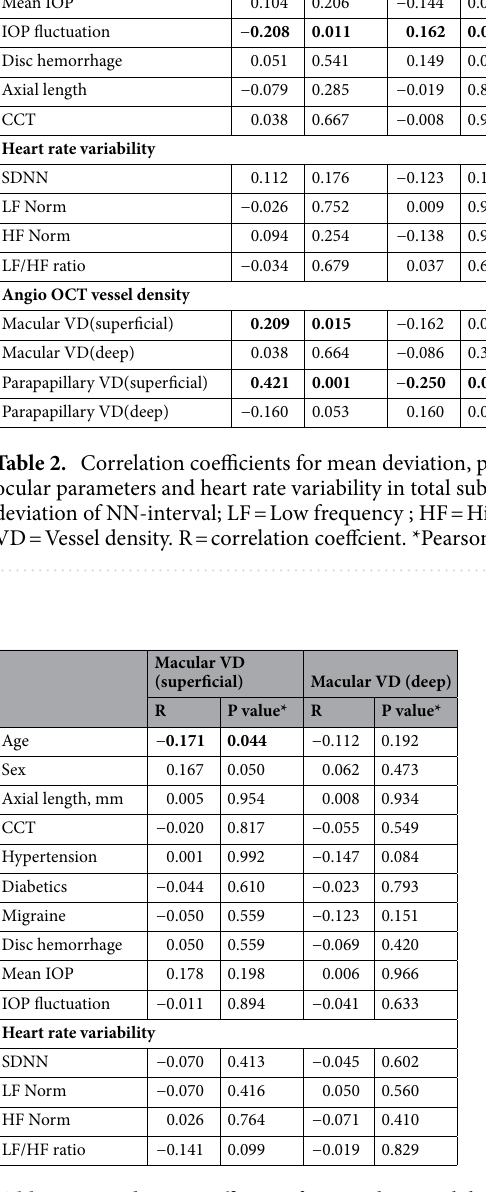
Table 3. Correlation coefficients for macular vessel density with ocular parameters and heart rate variability in total subjects. VD = Vessel density; IOP = intraocular pressure; SDNN = Standard deviation of NN-interval; LF = Low frequency ; HF = High frequency. R = correlation coeffcient. *Pearson correlation